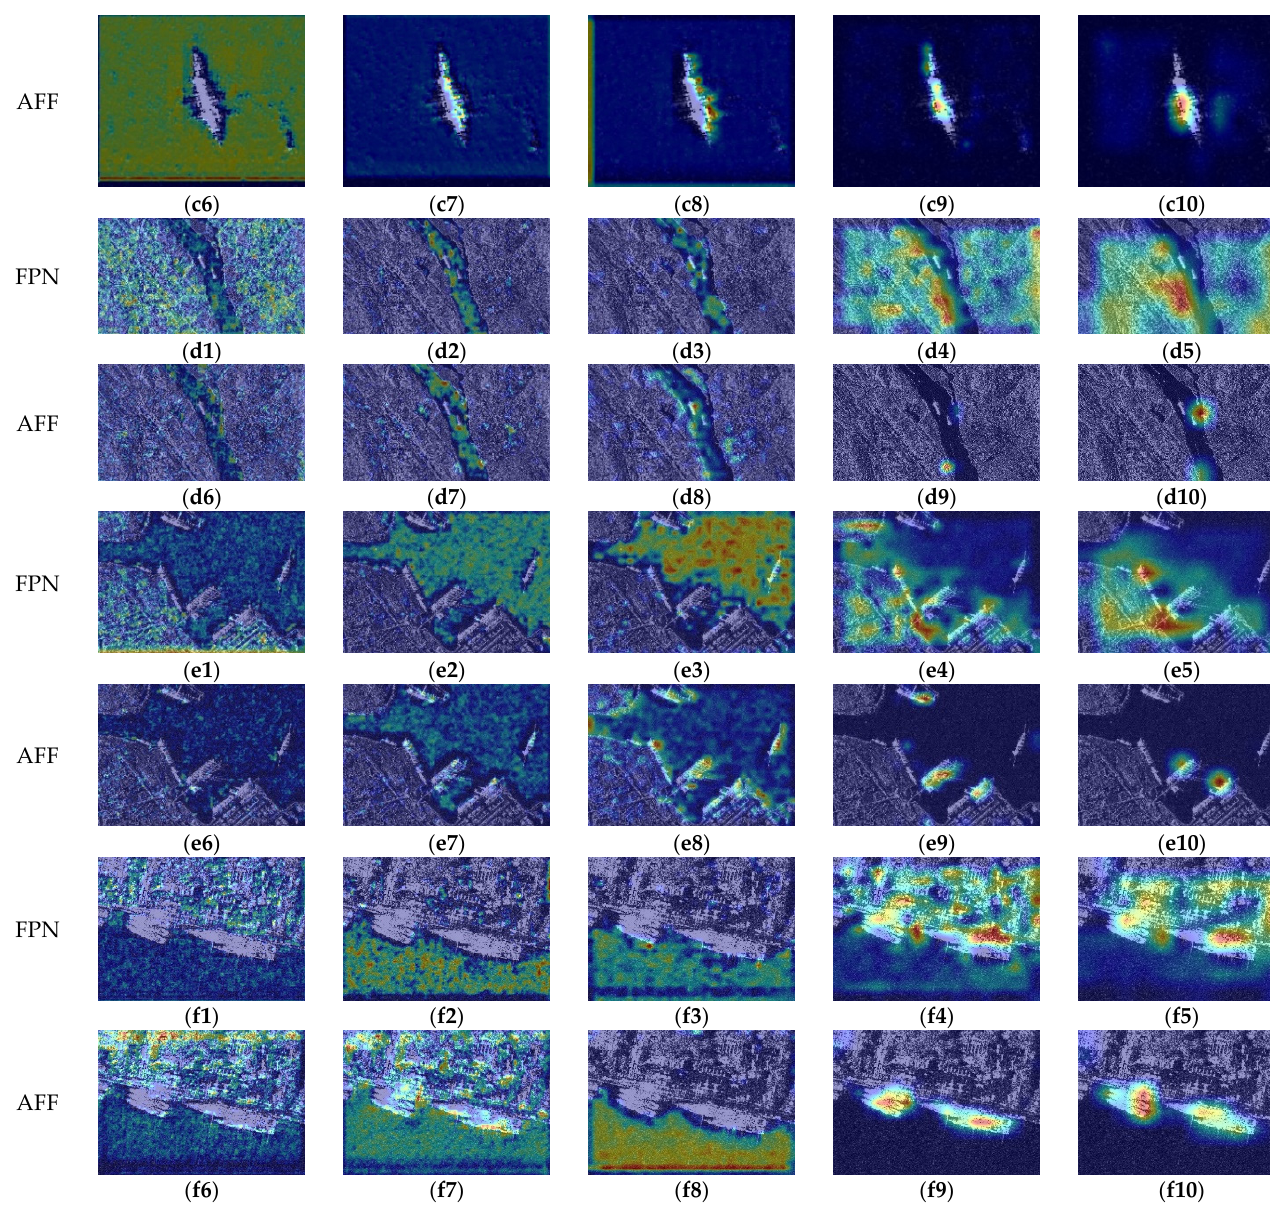
Figure 10. Results of AFF effect comparison. ( a – c ): images of small, medium, and large ships in the far-sea region; ( d – f ): images of small, medium, and large ships in the near-shore region. ( 1 – 5 ): feature fusion results of five scales of FPN; ( 6 – 10 ): feature fusion results of five scales of AFF.